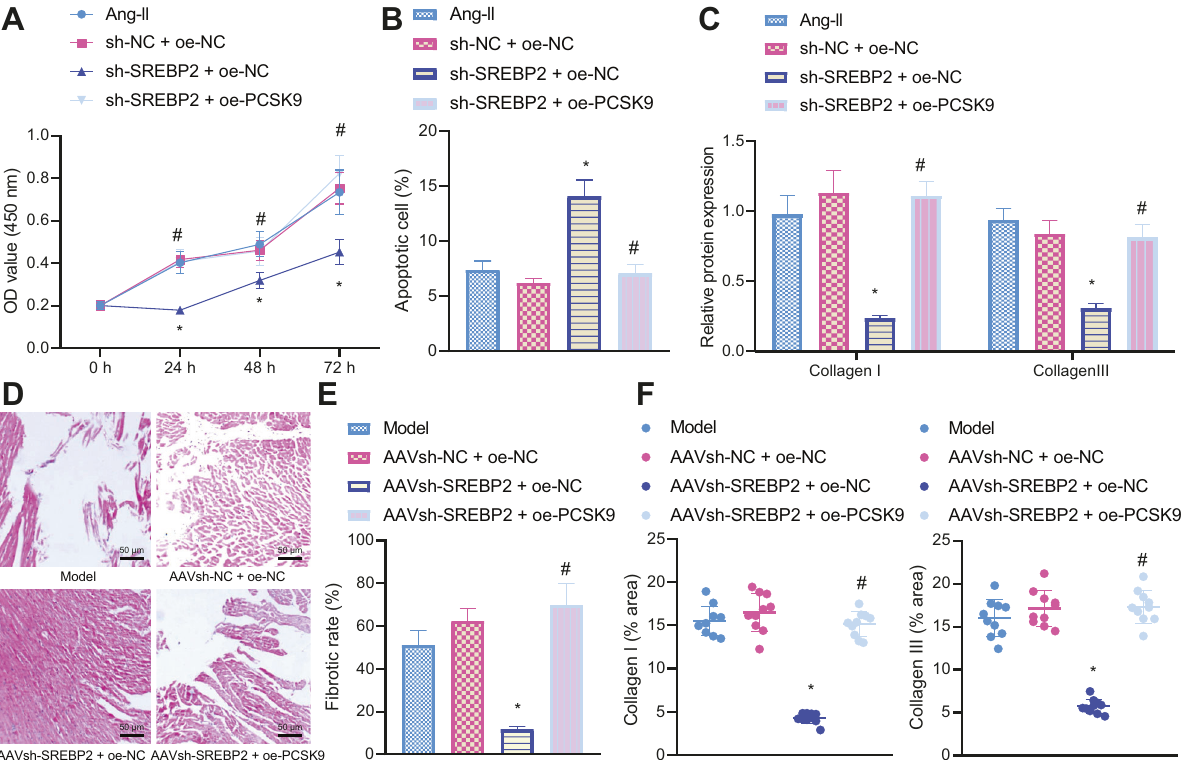
Fig. 6 SREBP2 elevates PCSK9 to accelerate atrial fi brosis in vivo. A CCK-8 detection of cell viability in HL-1 cells treated with sh-SREBP2 or combined with oe-PCSK9. B TUNEL detection of apoptosis of HL-1 cells treated with sh-SREBP2 or combined with oe-PCSK9. C Western blot analysis of collagen I and collagen III proteins in HL-1 cells treated with sh-SREBP2 alone or in combination with oe-PCSK9. D HE staining of pathological changes of atrial tissues of Ang II-induced mice treated with sh-SREBP2 or combined with oe-PCSK9. E Masson ’ s trichrome staining of atrial fi brosis degree in Ang II-induced mice treated with sh-SREBP2 or combined with oe-PCSK9. F IHC analysis of collagen I and collagen III proteins in atrial tissues of Ang II-induced mice treated with sh-SREBP2 or combined with oe-PCSK9. * p < 0.05, compared with Ang II-induced mice treated with sh-NC + oe-NC. # p < 0.05, compared with the Ang II-induced mice treated with sh-SREBP2 + oe-NC. All experiments were repeated three times independently. n = 10 for mice in each